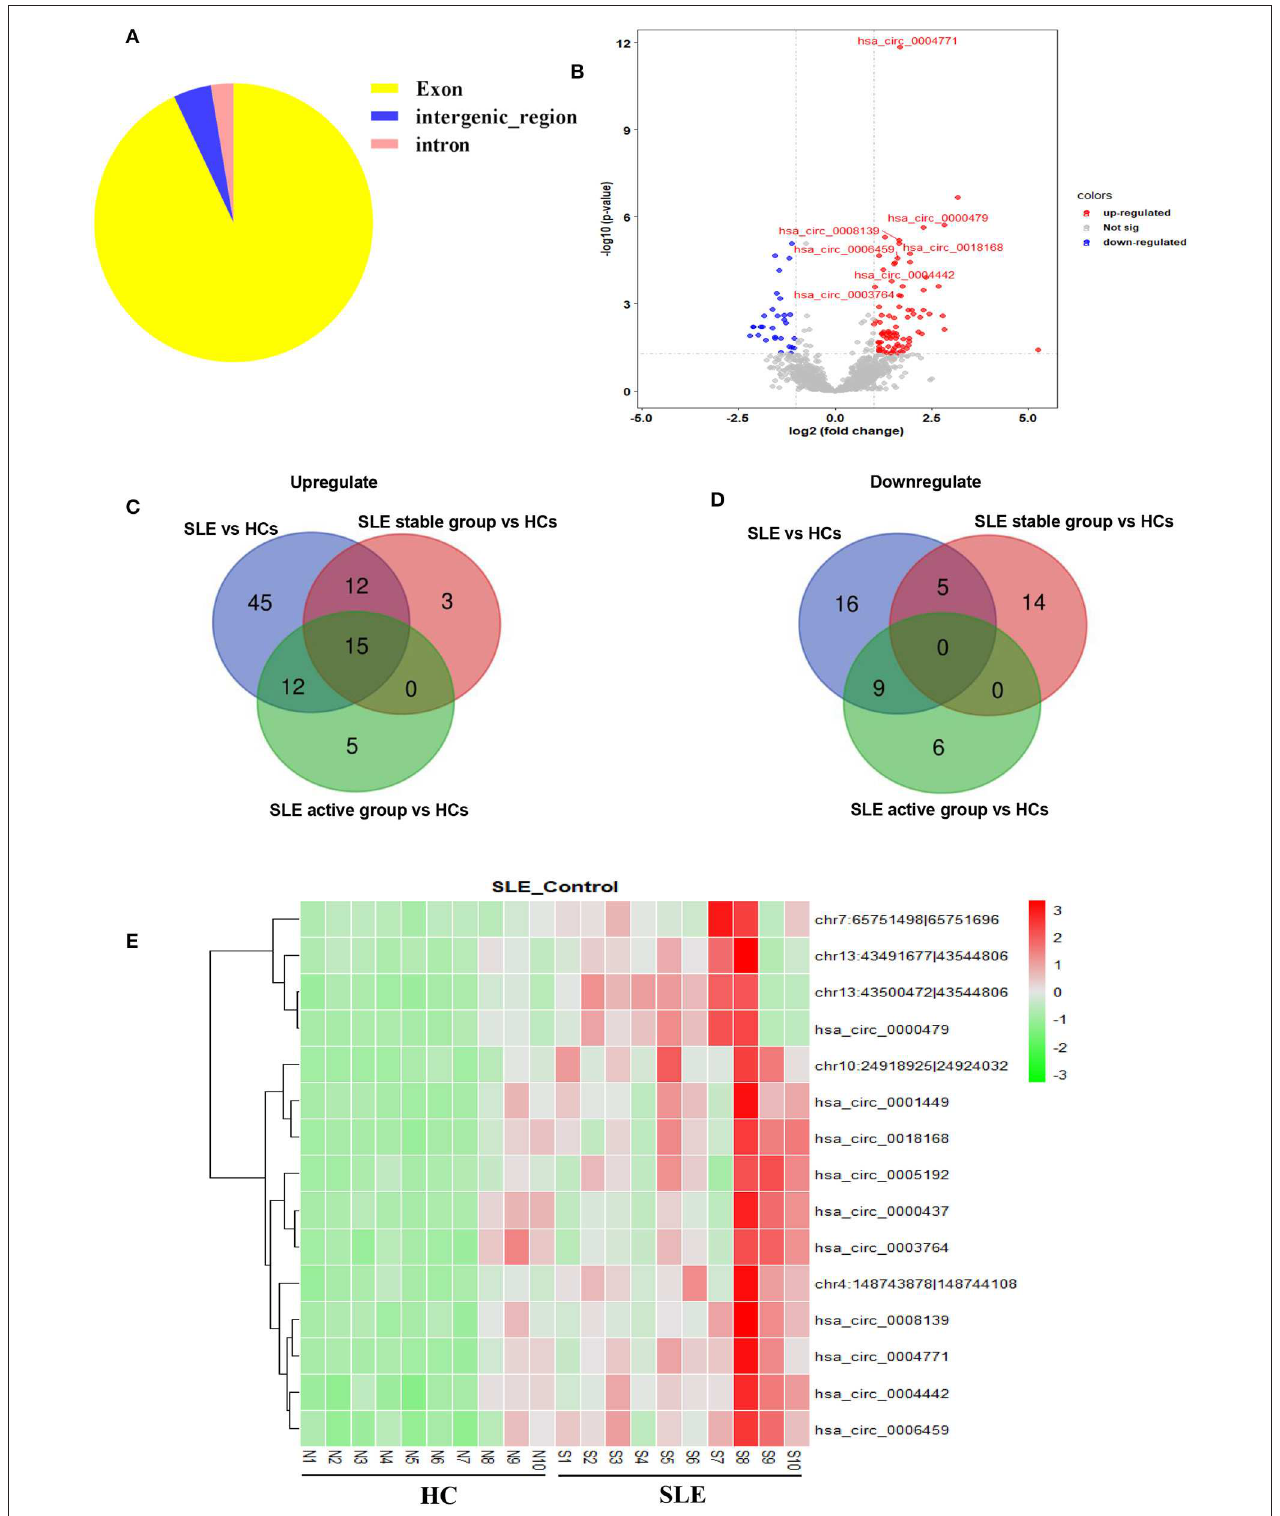
FIGURE 1 | Sequencing data on differential circRNA expression profiles in PBMCs from SLE patients and HCs in the discovery-phase cohort. (A) The percentage of significantly differentially expressed circRNAs arising from different genomic regions (exon, intron, and intergenic regions). (B) Volcano plot of differentially expressed circRNAs. The blue spots indicate significantly downregulated circRNAs, and the red spots indicate significantly upregulated circRNAs. (C,D) The overlapping